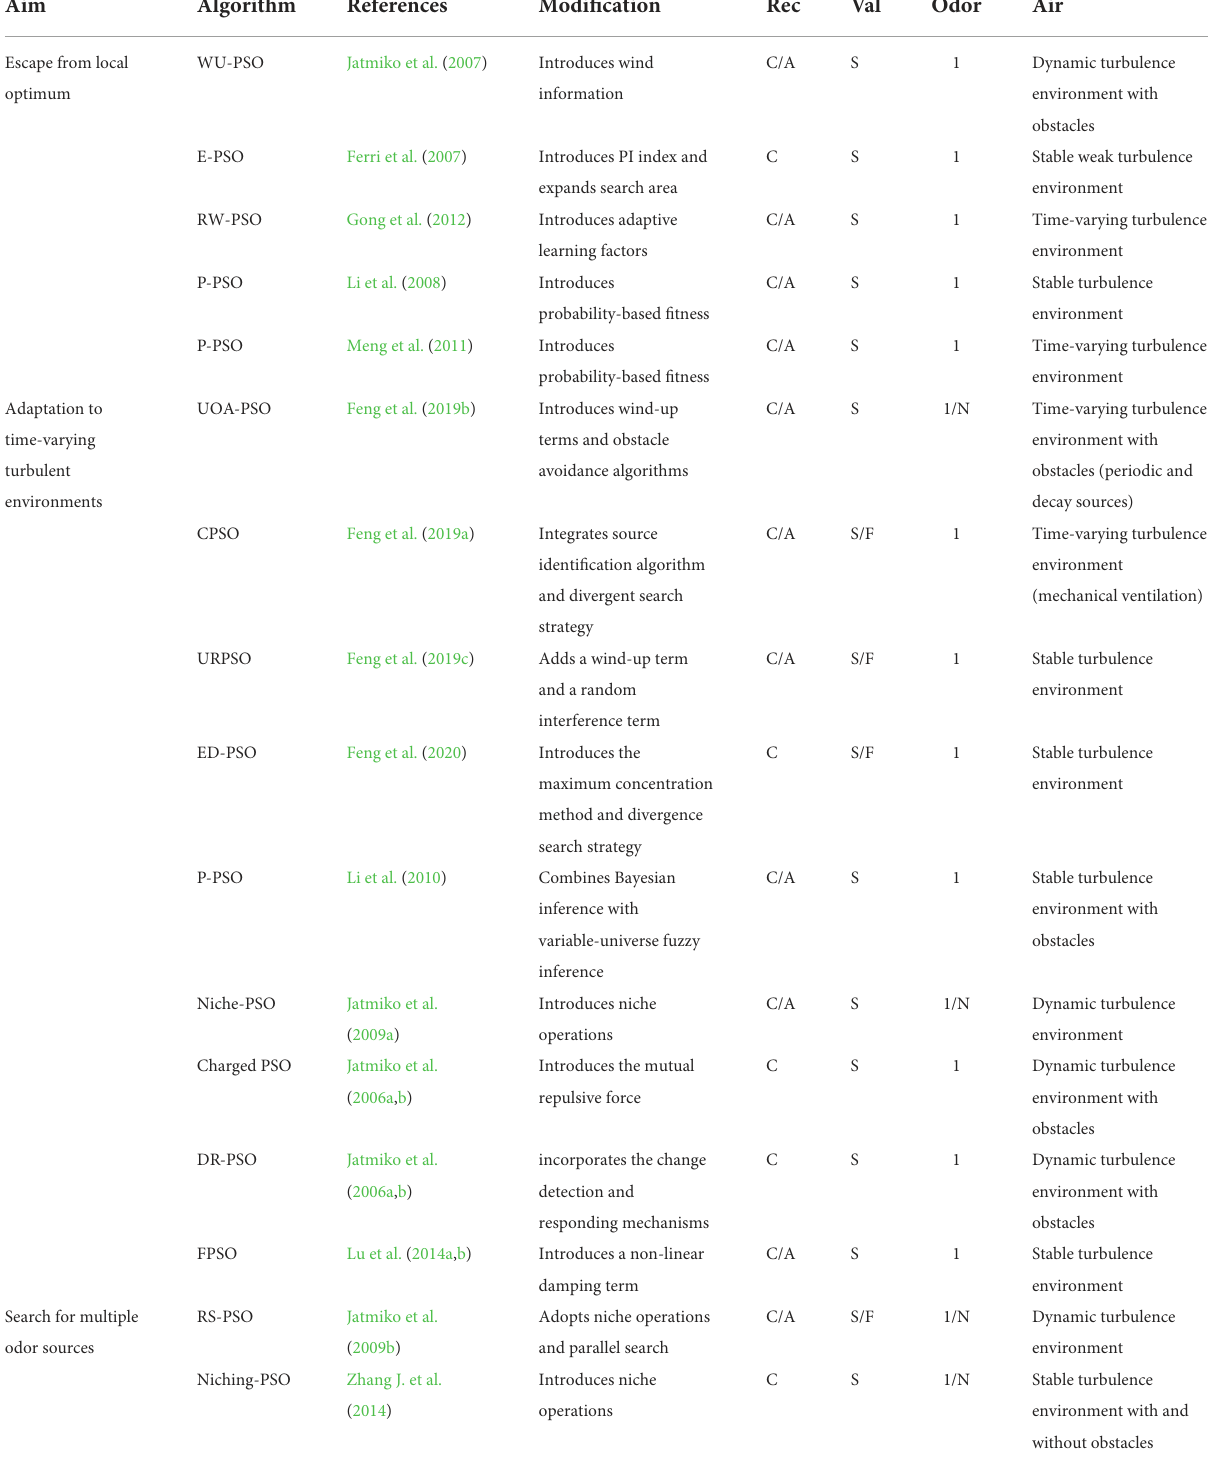
TABLE 1 Summary of the modified PSOs for odor source